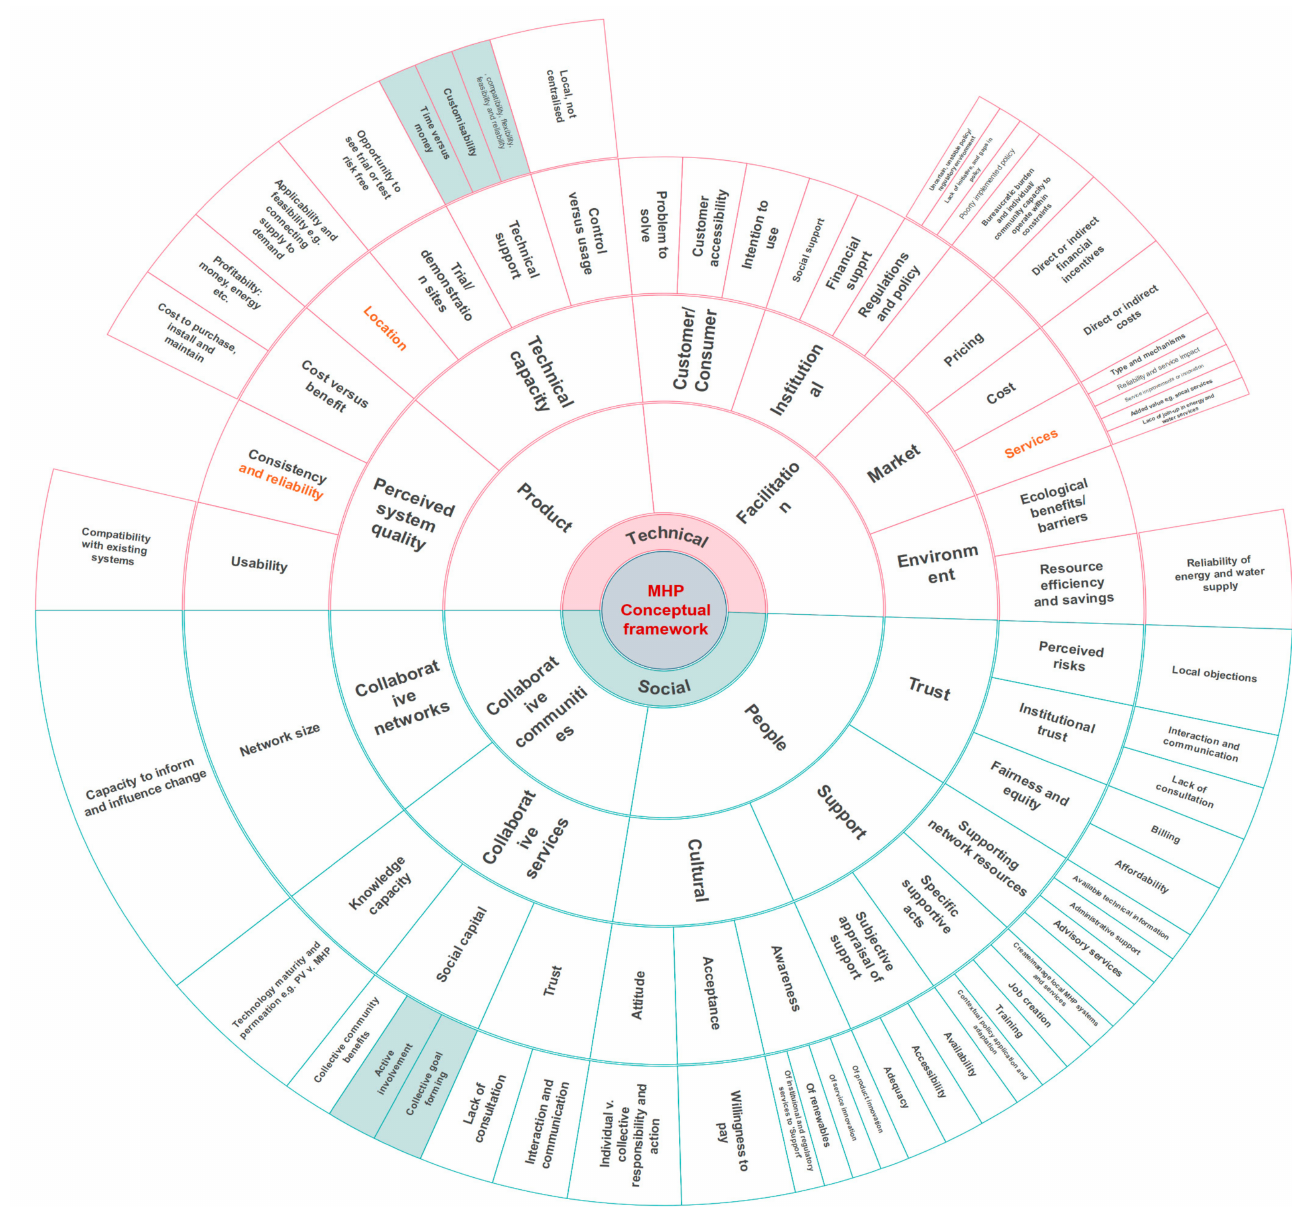
Figure 8. Validated conceptual framework for the viability and adoption of MHP (missing discounted themes, new sub-themes highlighted in